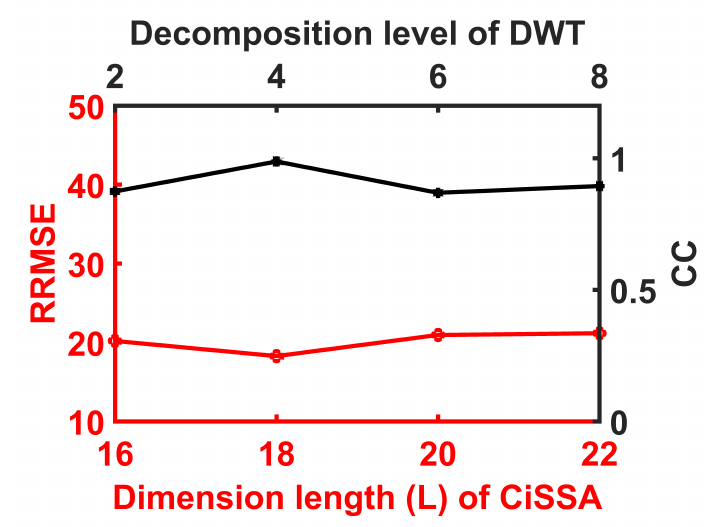
Figure 9. Plot shows variance of RRMSE and CC values of CiSSA-DWT tuning